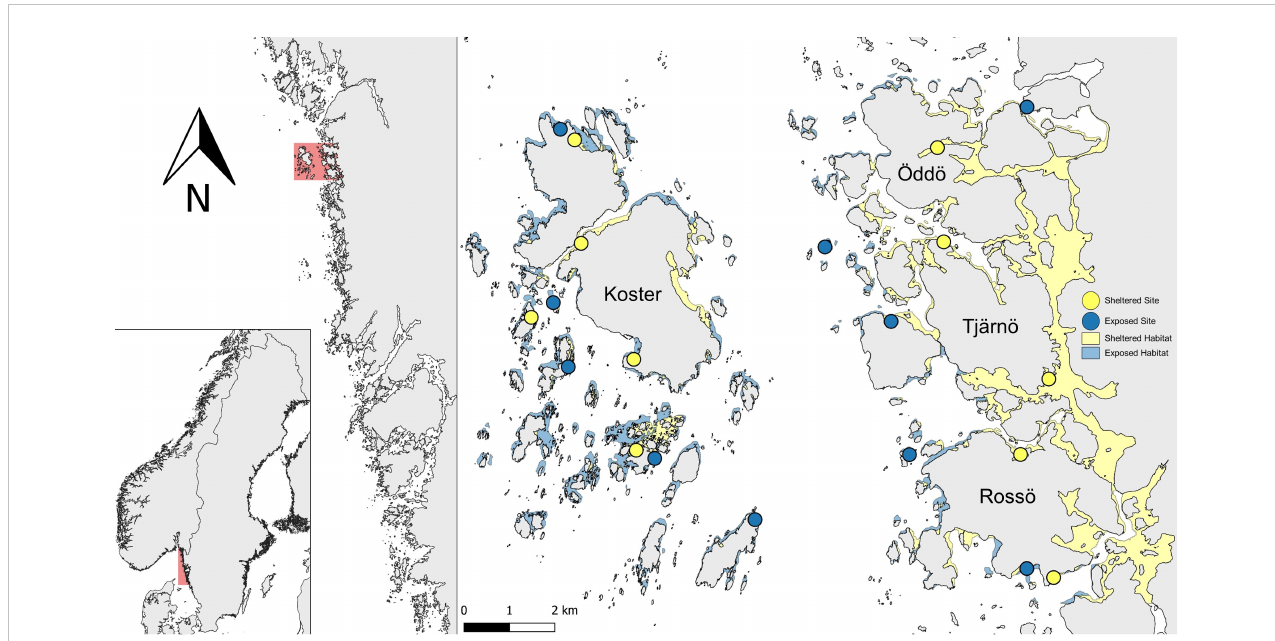
FIGURE 1 Map of study area and sampling sites on the Swedish west coast. Shallow habitat (<2 m depth) is shown in blue for exposed, and yellow for sheltered. Sampled sites are shown as circles in blue for exposed and yellow for sheltered. Note that small differences in exposure can be obscured by the symbols for sample